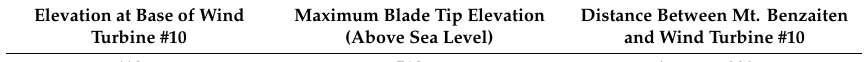
Figure 3. Relative locations of Mt. Benzaiten (elevation 519 m) and wind turbine #10. Table 1. Elevation information for wind turbine #10 and distance between Mt. Benzaiten (elevation 519 m) and wind turbine #10.